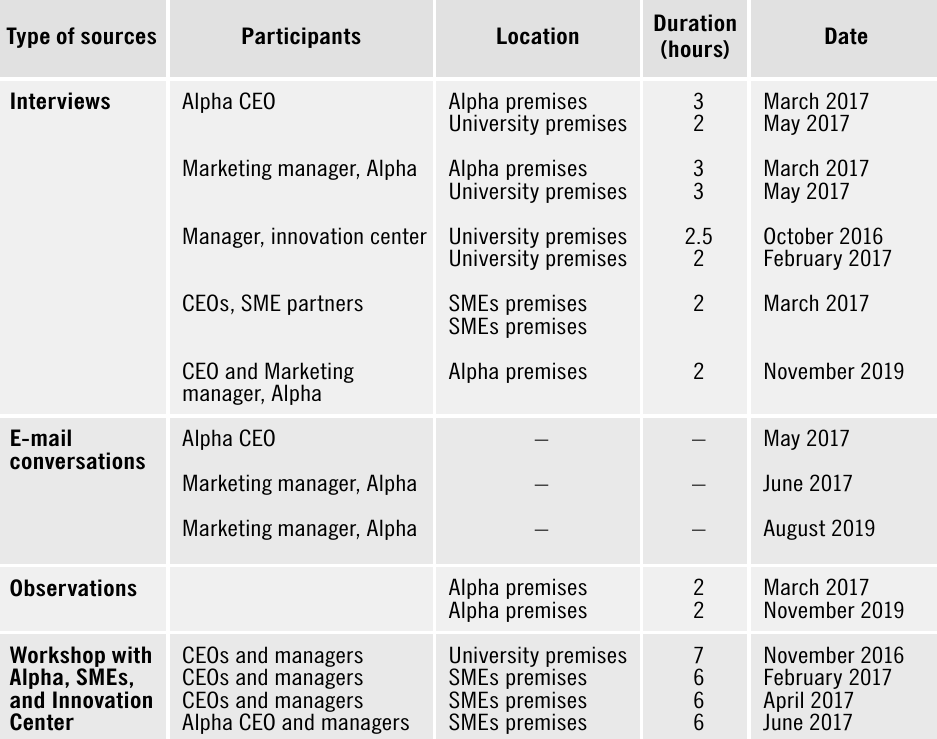
Table 1. Information on data collection Type of